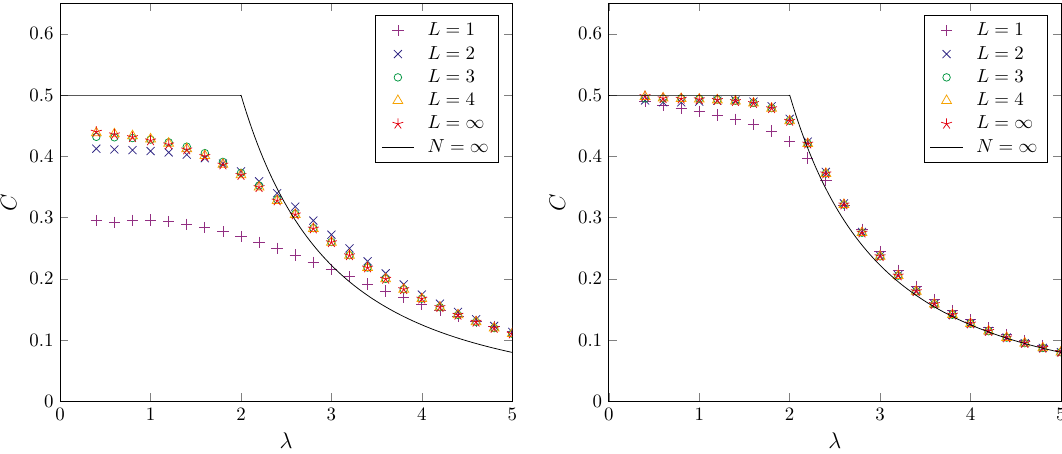
Figure 14 . The specific heat C defined in (5.3) is plotted against the ’t Hooft coupling constant λ for the SU (3) (Left) and SU (10) (Right) gauge theories with various L using D cut = 64 . The solid line represents the large- N limit obtained analytically as